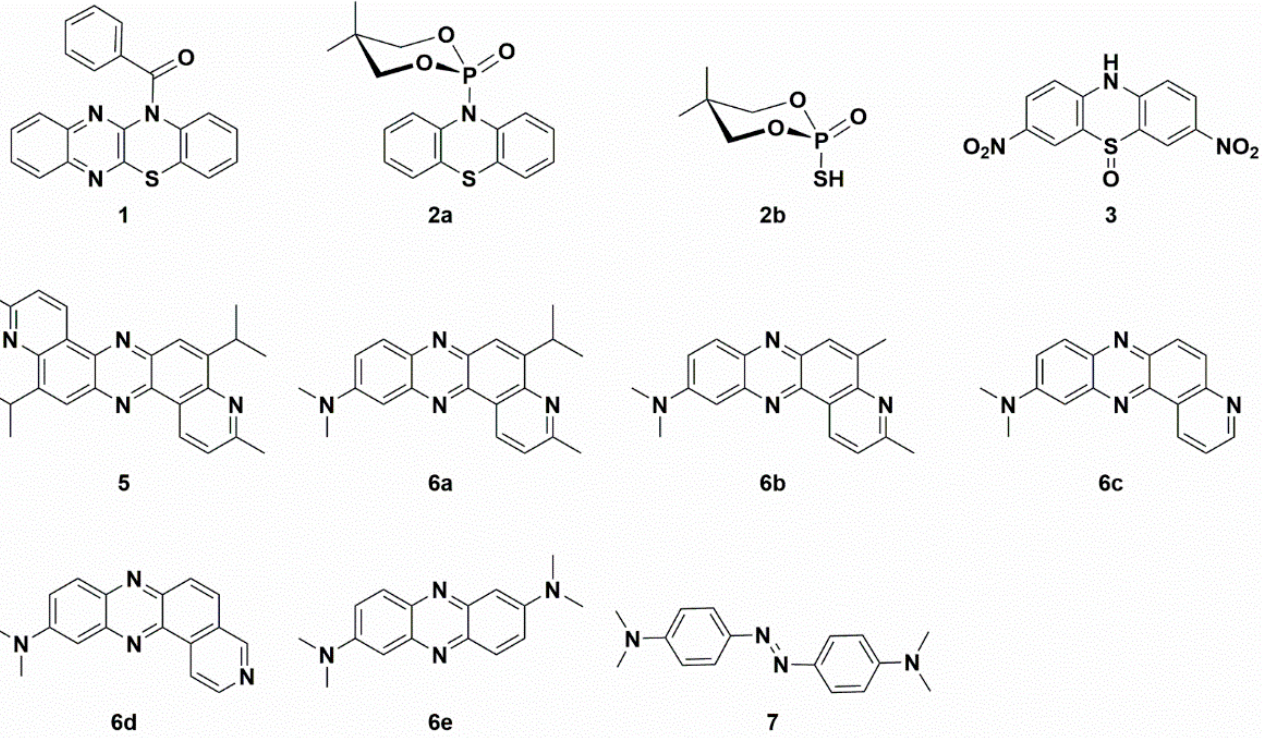
Scheme 1. Summary of the molecular structures of studied compounds.